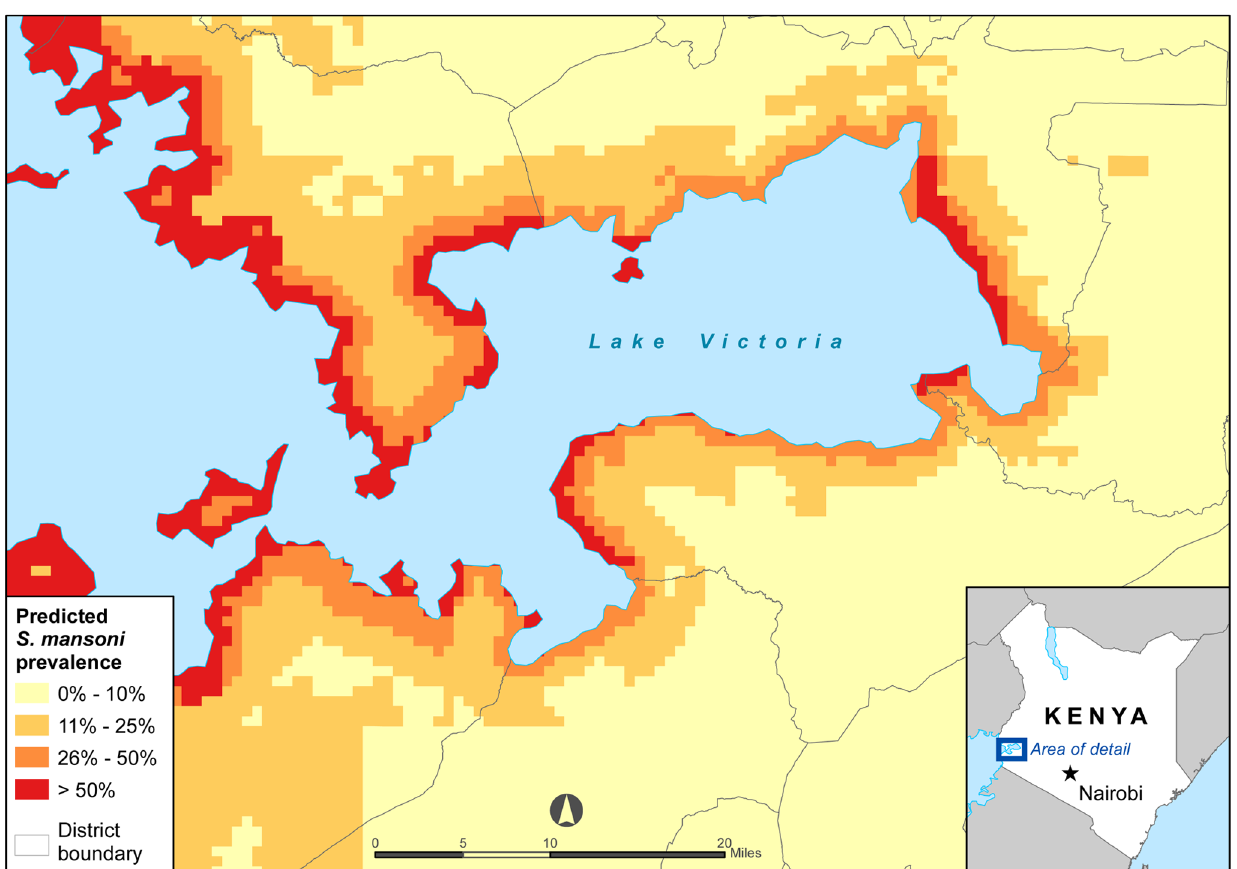
Figure 3. Predicted S.mansoni prevalence in Nyanza Province, Kenya.